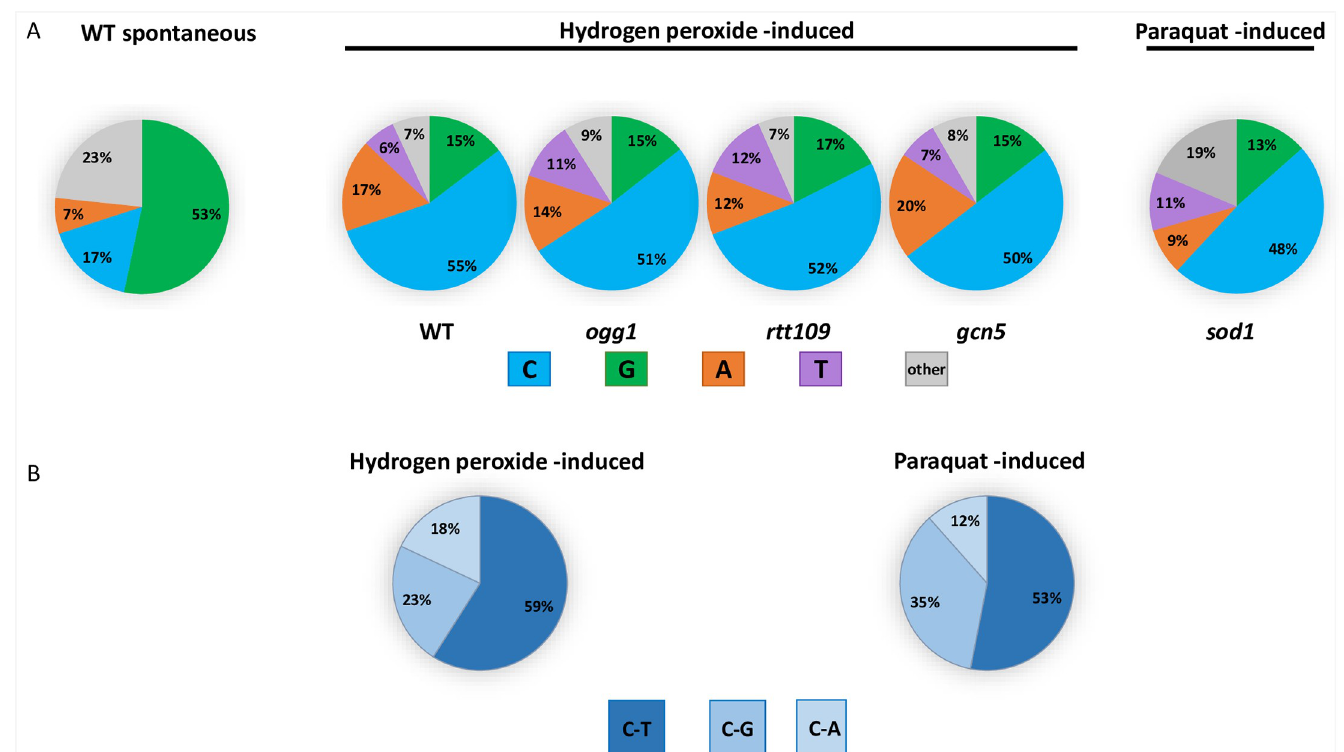
Fig 4. In ssDNA the majority of hydrogen peroxide–and paraquat-induced substitutions in sequenced CanR Red, closely spaced mutants are C to T transitions. A. Spectra of mutations identified by Sanger sequencing of CanR Red isolates in the triple subtelomeric reporter. 131, 141, 146, and 111 hydrogen peroxide–induced mutations had been detected in wt , rtt109 , gcn5 , and ogg1 strains, respectively. The differences in spectra of mutations for each mutant background compared to wt are not statistically significant by pairwise chi-squared tests ( P = 0.4, 0.5, and 0.6 for rtt109 , gcn5 , and ogg1 strains, respectively). The difference between spontaneous and hydrogen peroxide–induced spectra of mutations in wt strains is significant, P < 0.0001. See also S1 Data. B. C to T transitions constitute the majority of mutations at Cs. Left panel: combined data for all of the hydrogen peroxide–induced substitutions at C in ssDNA in all genetic backgrounds tested; right panel: data for paraquat- induced substitutions in sod1 strains. See also S1 Data. CanR Red, canavanine-resistant red; ssDNA, single-strand DNA; wt,